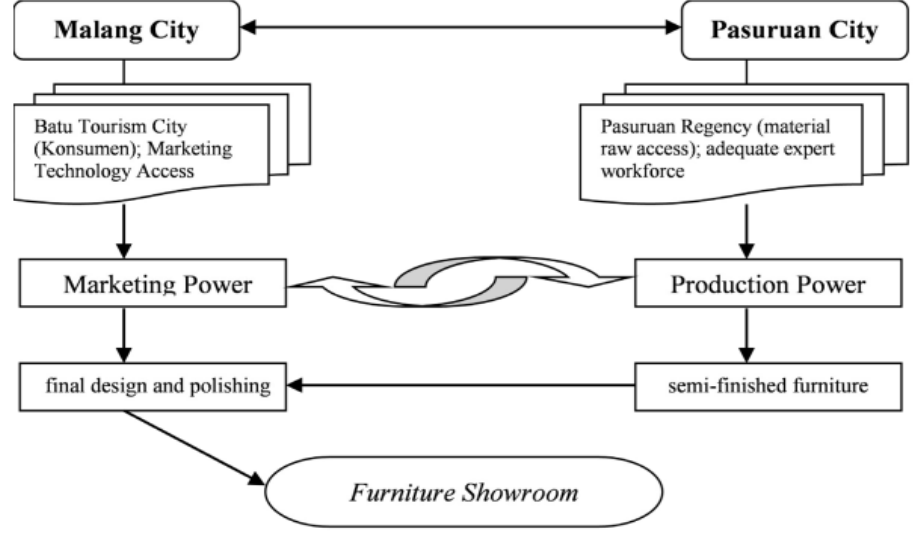
Figure 1: Pattern of Furniture SME Inter-Clustering